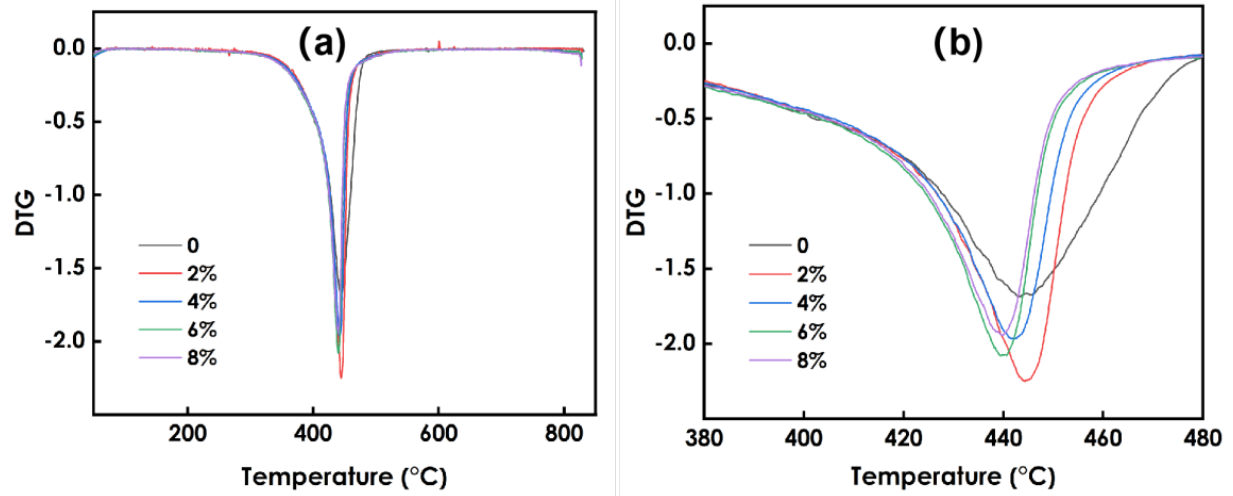
Figure9. DTG data of coating sprepared using different amounts of WO 3 : ( a ) the temperature between 0 − 800 ℃ , ( b ) the temperature between 380 − 480 ℃ .